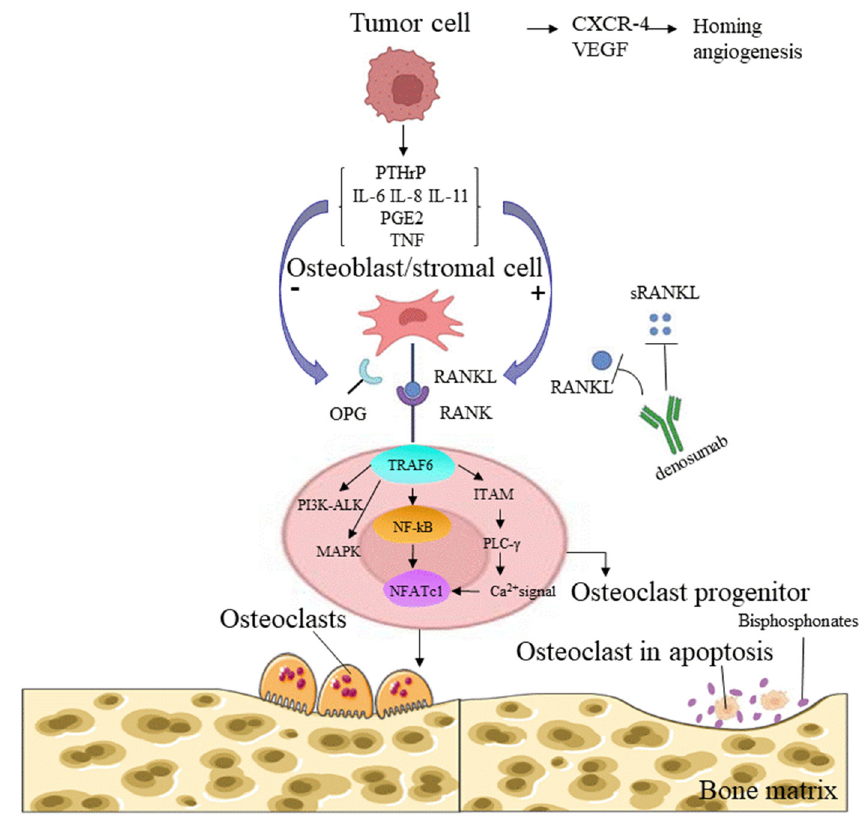
Figure 2. RANKL-RANK signaling in osteolytic bone metastases. Tumor cells arriving in the bone marrow microenvironment secrete tumor-related factors, such as CXCR-4 and VEGF, to promote the colonization and survival of tumor cells in the bone marrow, and PTHrP, IL-6, IL-8, IL-11, PGE2, and TNF stimulate osteoblasts and stromal cells to produce RANKL, which binds to the RANK expressed on osteoclasts. The interaction of RANKL and RANK promotes osteoclast survival and differentiation, and mature osteoclasts eventually cause bone resorption. Osteoblasts also produce OPG, which inhibits bone resorption by competing with RANK to bind to RANKL. The binding of the human monoclonal antibody denosumab to RANKL inhibits bone destruction, by blocking the RANKL-RANK axis. Bisphosphonates inhibit osteoclast activity and the growth of tumor cells, and exert an osteoprotective effect [121]. CXCR-4 = chemokine (C-X-C motif) re- ceptor 4; VEGF = vascular endothelial growth factor; PTHrP = parathyroid hormonerelated pep- tide; IL-6 = interleukin-6; IL-8 = interleukin-8; IL-11 = interleukin-11; PGE2 = prostaglandin E2; TNF = tumor necrosis factor; RANKL = receptor activator of NF-kappa B ligand; RANK = receptor activator of NF-kappa B; OPG =